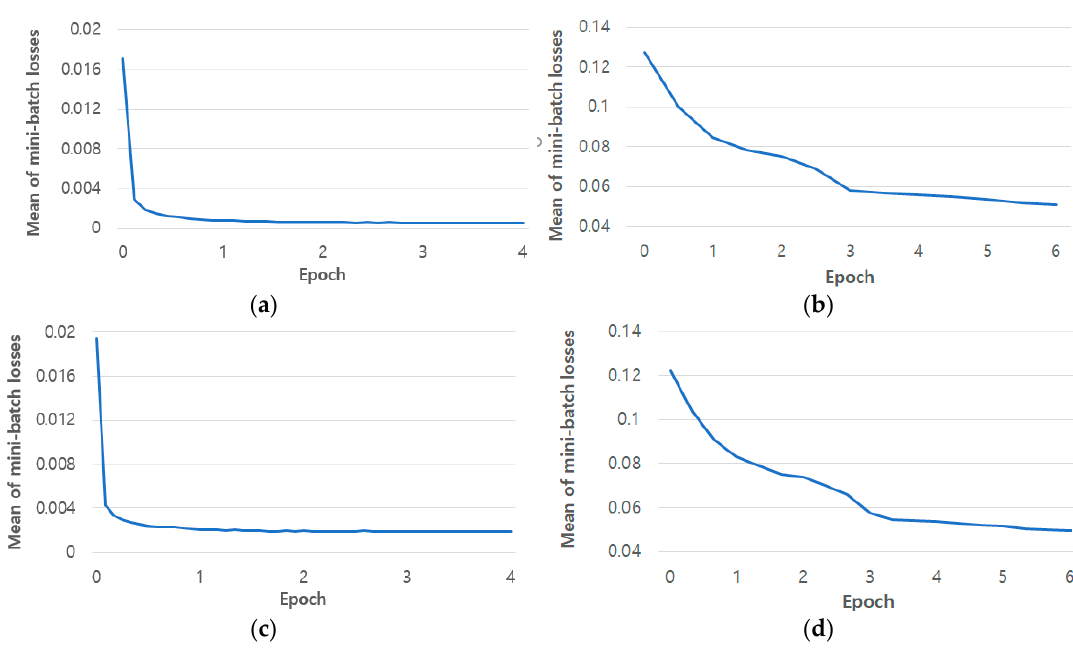
Figure 17. Loss graphs during faster R-CNN training in two-fold cross validation. ( a ) RPN losses from the 1st fold validation; ( b ) classifier losses from the 1st fold validation; ( c ) RPN losses from the 2nd fold validation; ( d ) classifier losses from the 2nd fold validation.